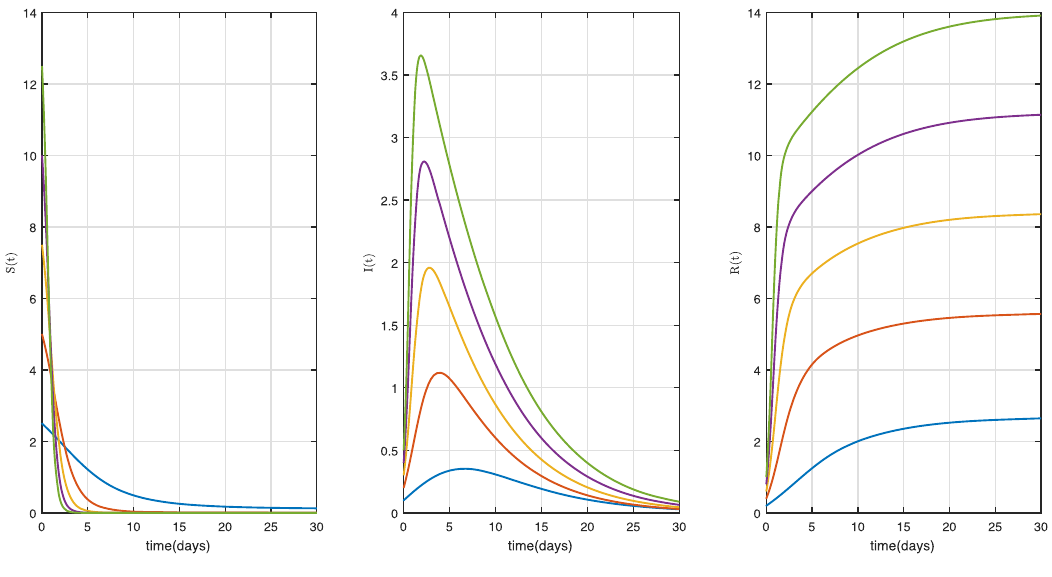
Figure 2: Time evolution of the rumor.